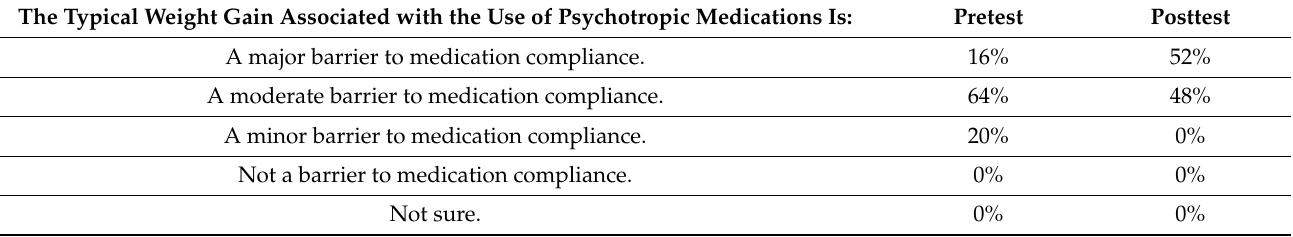
Table 6. Questionnaire Item 17 Response Frequency